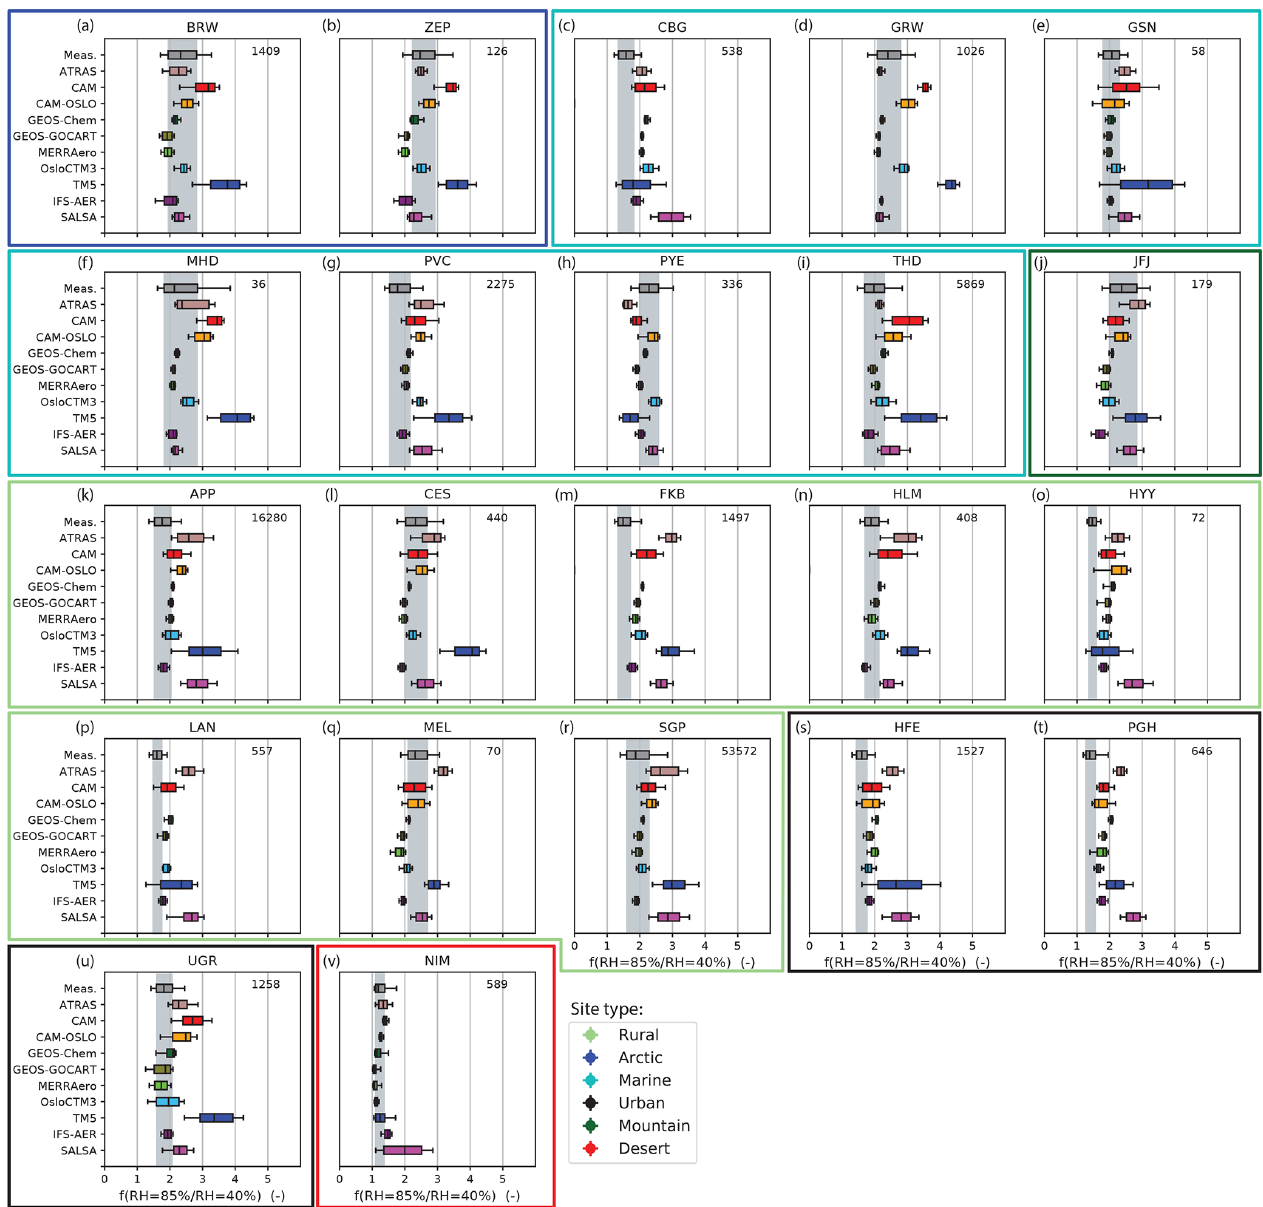
Figure 1. The scattering enhancement f (RH = 85% / RH ref = 40%) at λ = 550nm as measured and predicted by the various models for all investigated sites (panels a – v ). The box edges represent the 25th to the 75th percentiles (the gray underlying area represents the quartiles for all measurements), with the center line indicating the median. The whiskers show the range of the data extending from the 10th to 90th percentiles. The number in the top right corner indicates the number of available measurements at each site (temporal resolution shown in Table 1). The colored boxes grouping the different sets of plots indicate the site